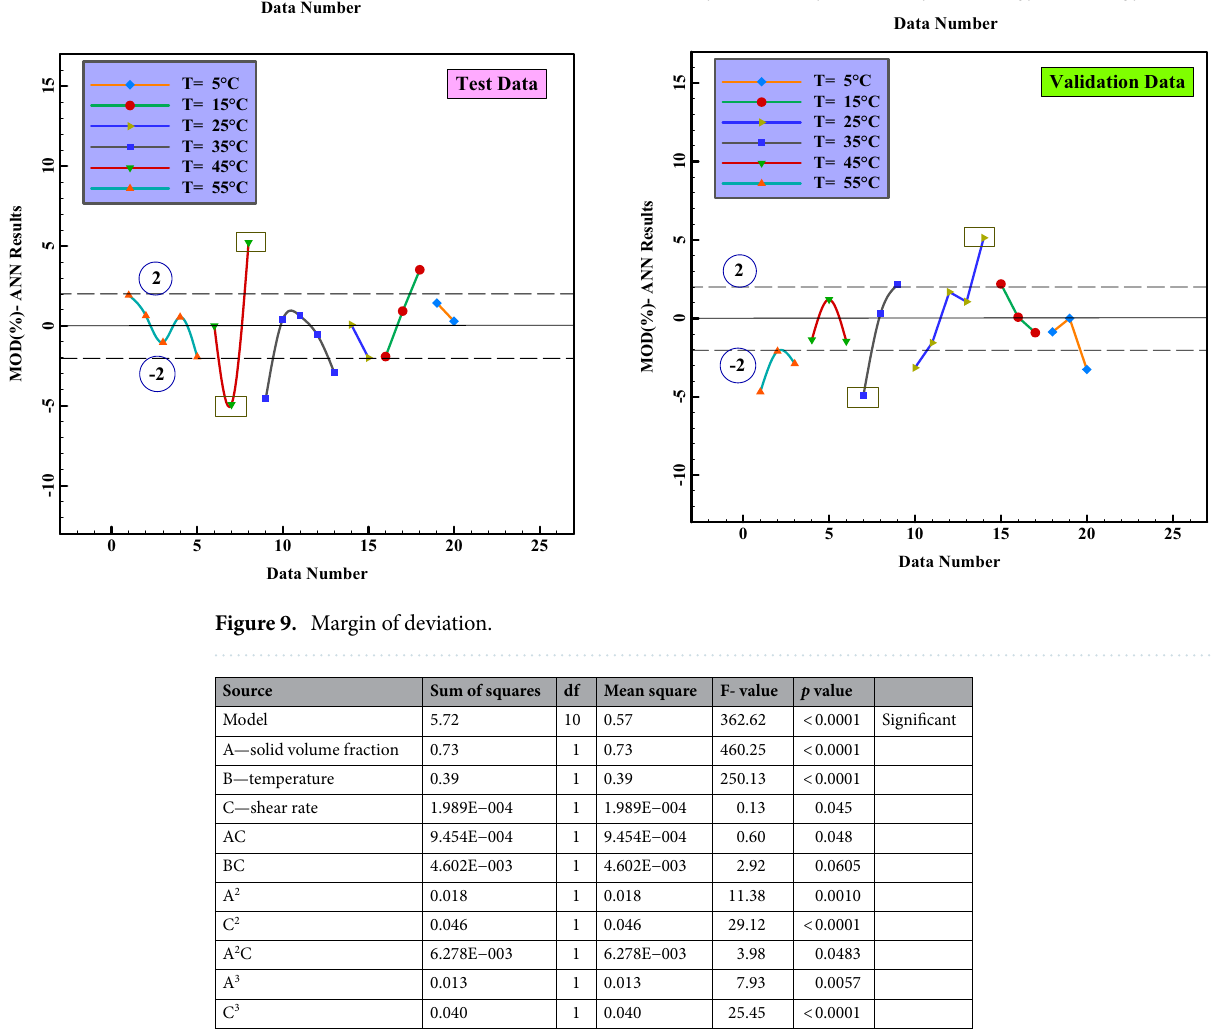
Table 2. Analysis of variance for proposed